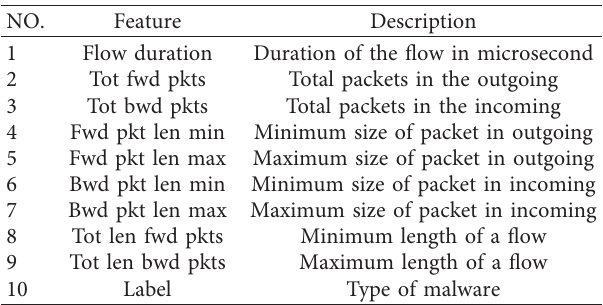
Table 4: Features that are most representative of the network traffic of malware and benign for the PCA method.